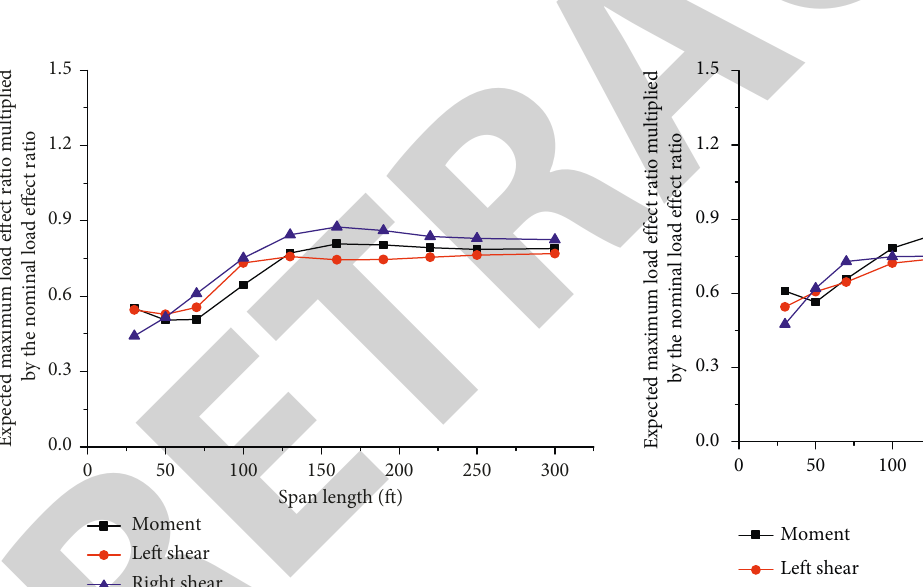
Figure 6: Mean value ratio in equation (8) for site 002 (with 20% allowance).